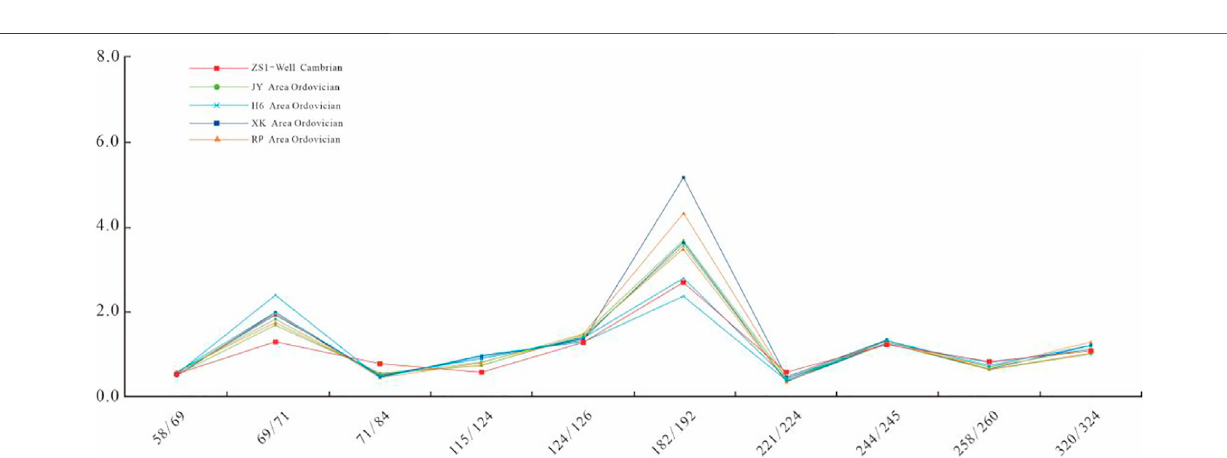
Frontiers in Earth Science |